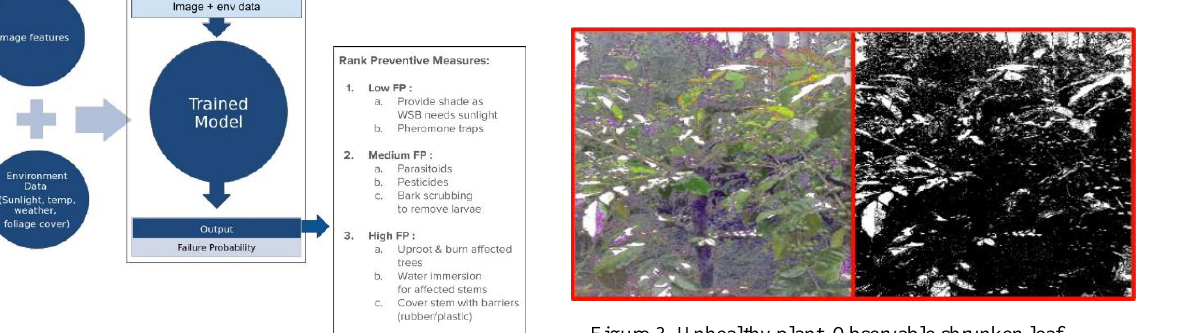
Figure 3. Unhealthy plant. Observable shrunken leaf size and reduced foliage cover. Image is prominently filled with black patches and shadows